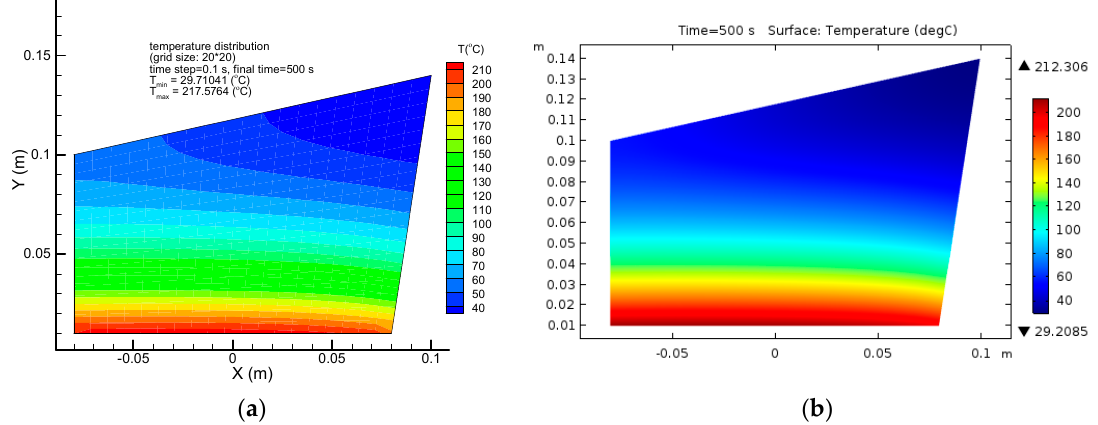
Figure 3. Validation of the direct problem solver using the finite element software COMSOL. The result obtained by using our explicit code ( a ) and the result obtained by using COMSOL ( b ).